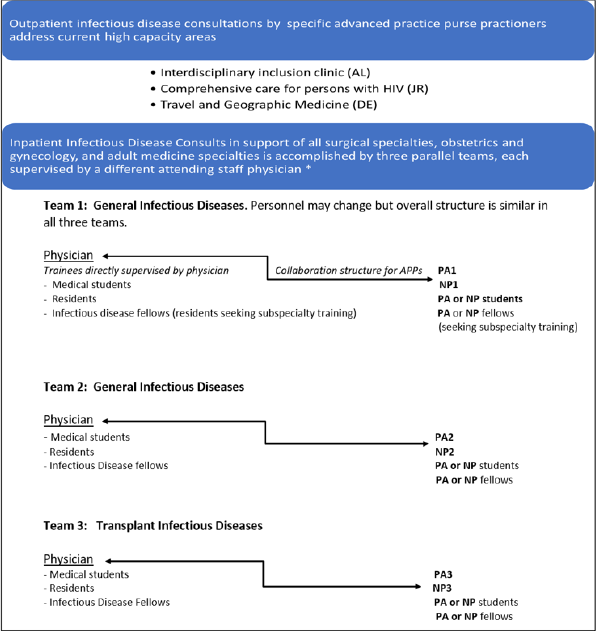
Figure 1 . Infectious Disease team and collaboration structure* * All pediatric infectious disease consoltations are made by separate pediatrics-infectious disease staff.